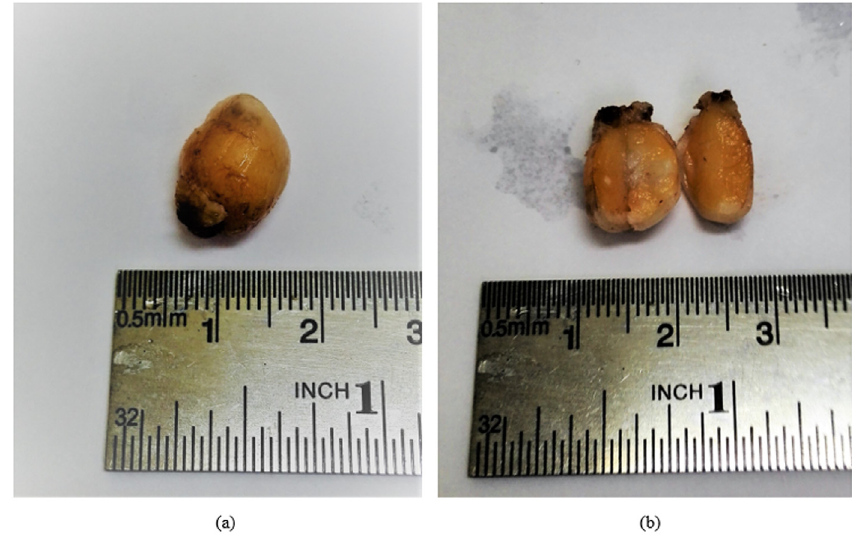
Fig. 2. Gross macroscopic fi ndings show a round to oval yellowish nodule measuring approximately 10 mm (cid:1) 13 mm (cid:1) 10mm with hard rubbery consistency (a). The bisected specimen showed a central whitish area on the cut surface surrounded by fatty tissue